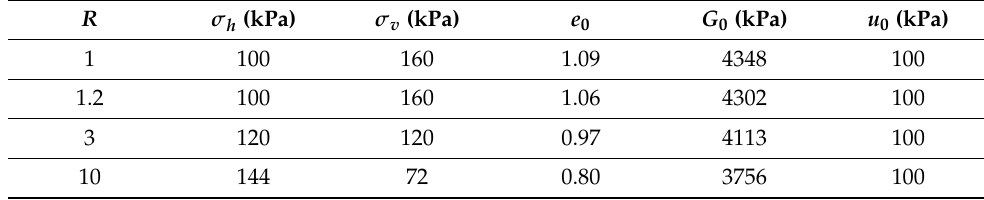
Table 2. Soil state parameters used in